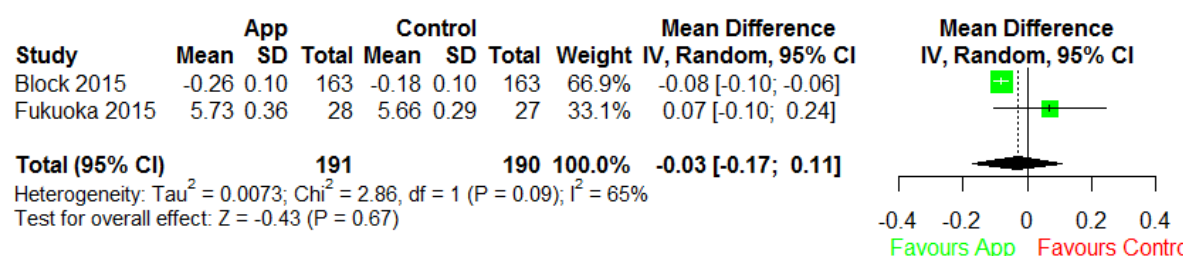
Figure 8. Forest plot the effect of prediabetes apps. IV: inverse